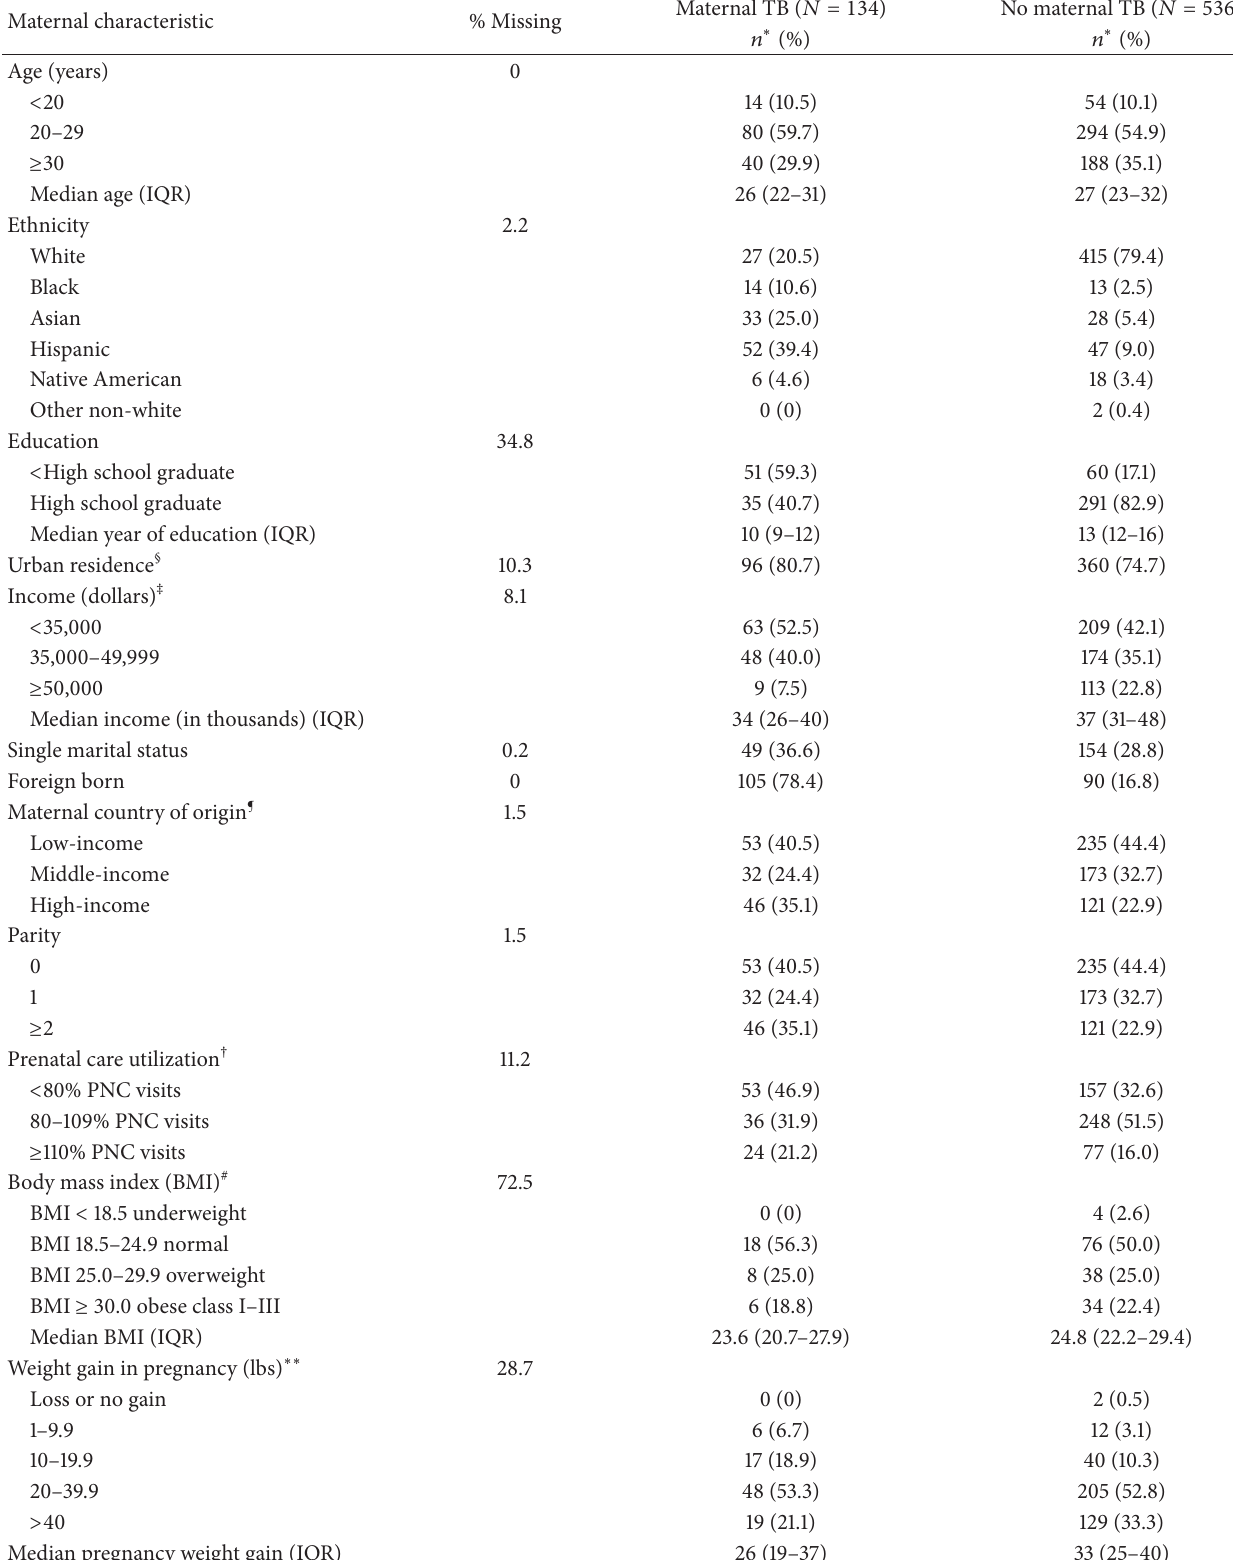
Table 1: Characteristics of women with and without tuberculosis-associated ICD-9 diagnosis during delivery hospitalization, Washington State,